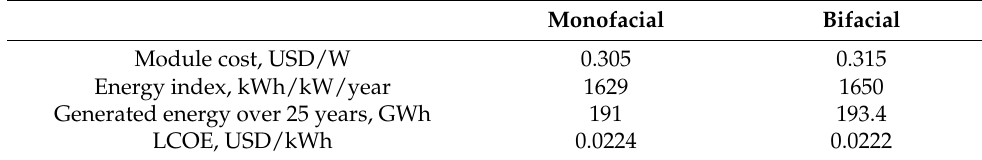
Table 4. Economic comparison of Bifacial against monofacial PV power plants.